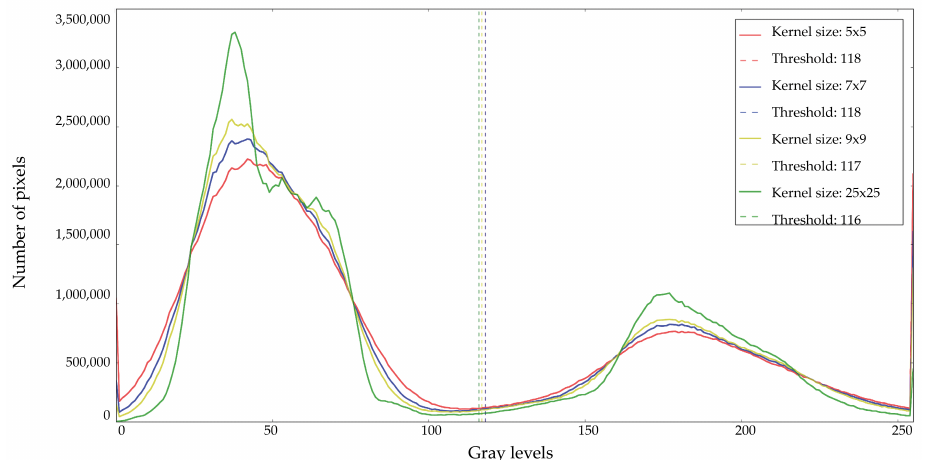
Figure 7. Pixel values distribution of the image denoised by means of kernel with different size.